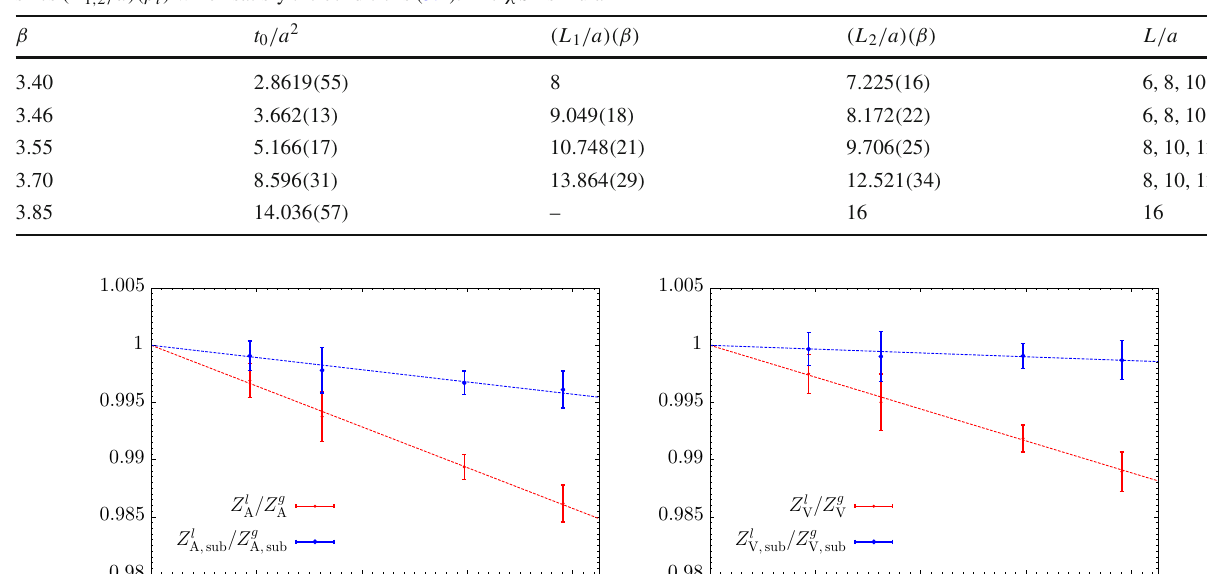
Table5 CLS β -valuesandcorrespondingresultsfor t 0 / a 2 intheSU(3) flavoursymmetriclimit[1,2].Thelatterareusedtodeterminethelattice sizes ( L 1 , 2 / a )(β i ) which satisfy the conditions (5.1). The χ SF simula-